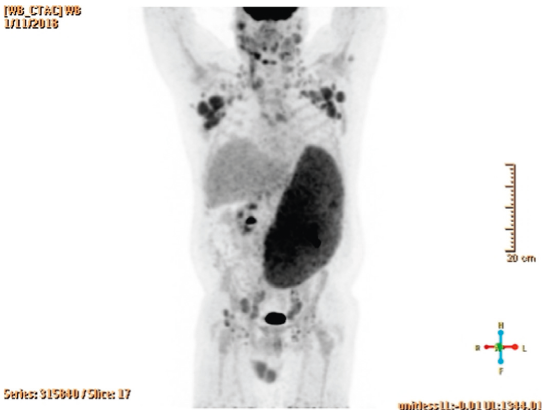
Figure 4: Case 2: PET imaging study confirmed massive spleno- megaly, spleen measuring 31 cm in craniocaudal dimension, and with diffusely hypermetabolic activity, SUV 5.6, considered to be in keeping with lymphomatous involvement. There were also nu- merous subcapsular wedge-shaped areas of photopenia and hypodensities measuring up to 3.5cm, which were suspected to be splenic infarcts.